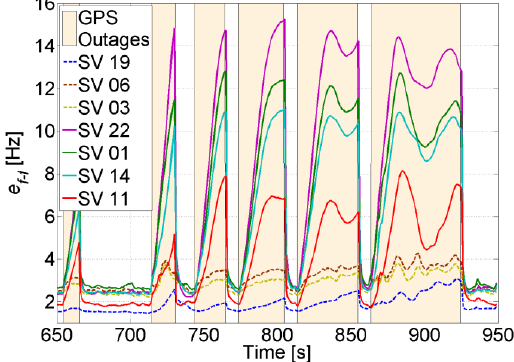
Figure 19. Feed-forward frequency uncertainty when 3 SVs 19, 06 and 03 are in